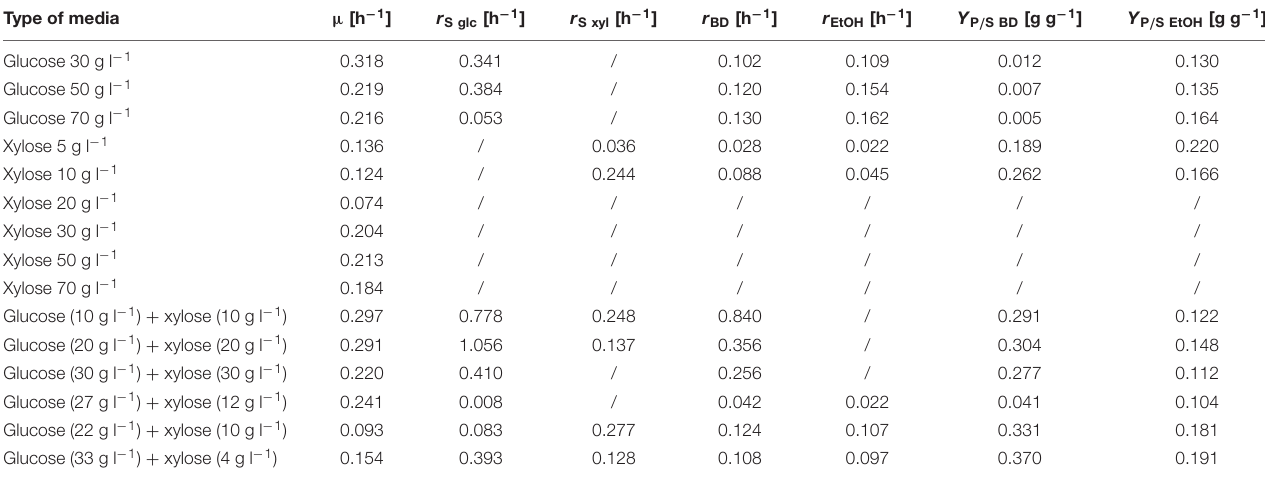
TABLE 3 | Specific growth rate, consumption of substrate and synthesis of product, and yield of cultivation of P. polymyxa DSM 742 on media with different carbon sources. Type of